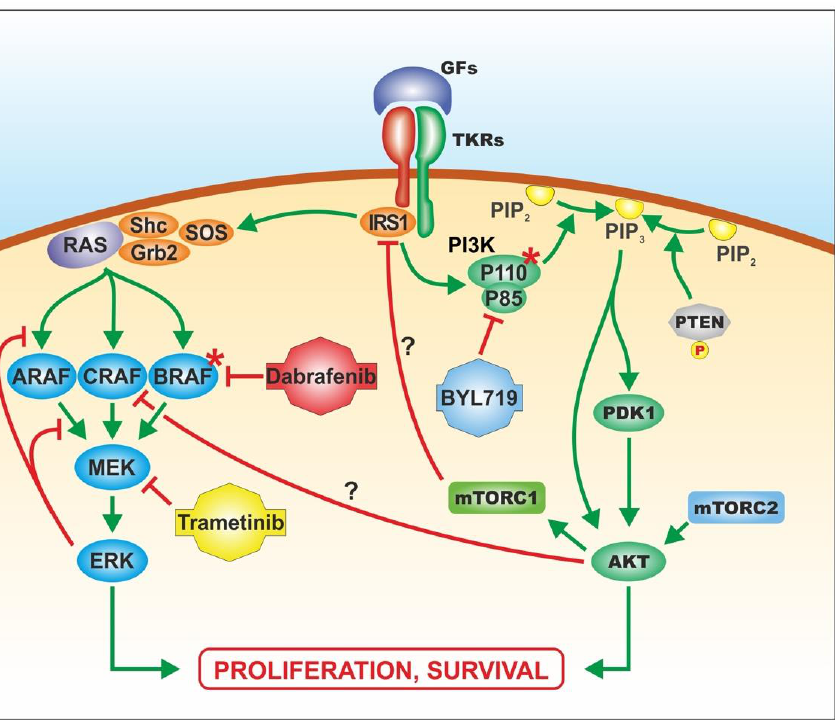
Figure 8. Crosstalk between the MAPK and PI3K–Akt pathways and interaction between BRAF-, MEK-, and PI3K-selective inhibitors with their molecular targets. * = Activating mutation As the MAPK and PI3K–Akt pathways may positively or negatively regulate mutual activities, the combination of BRAF or MEK inhibitors with a PI3K–Akt inhibitor was pro- posed to overcome the resistance to MAPK inhibitors in BRAF V600E mutant tumours [7]. However, the mechanisms by which such combinations may revert resistance to targeted therapy are still debated.